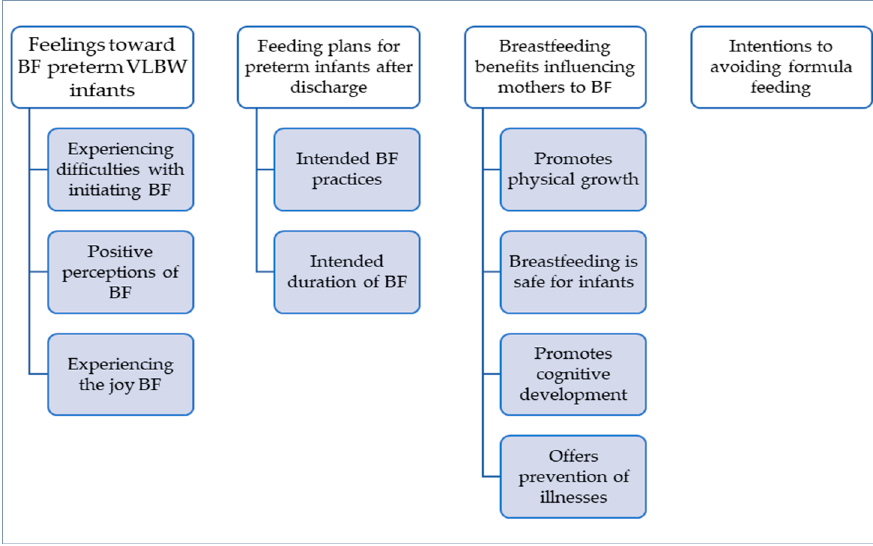
Figure 2. Summary of the themes and supporting sub-themes.